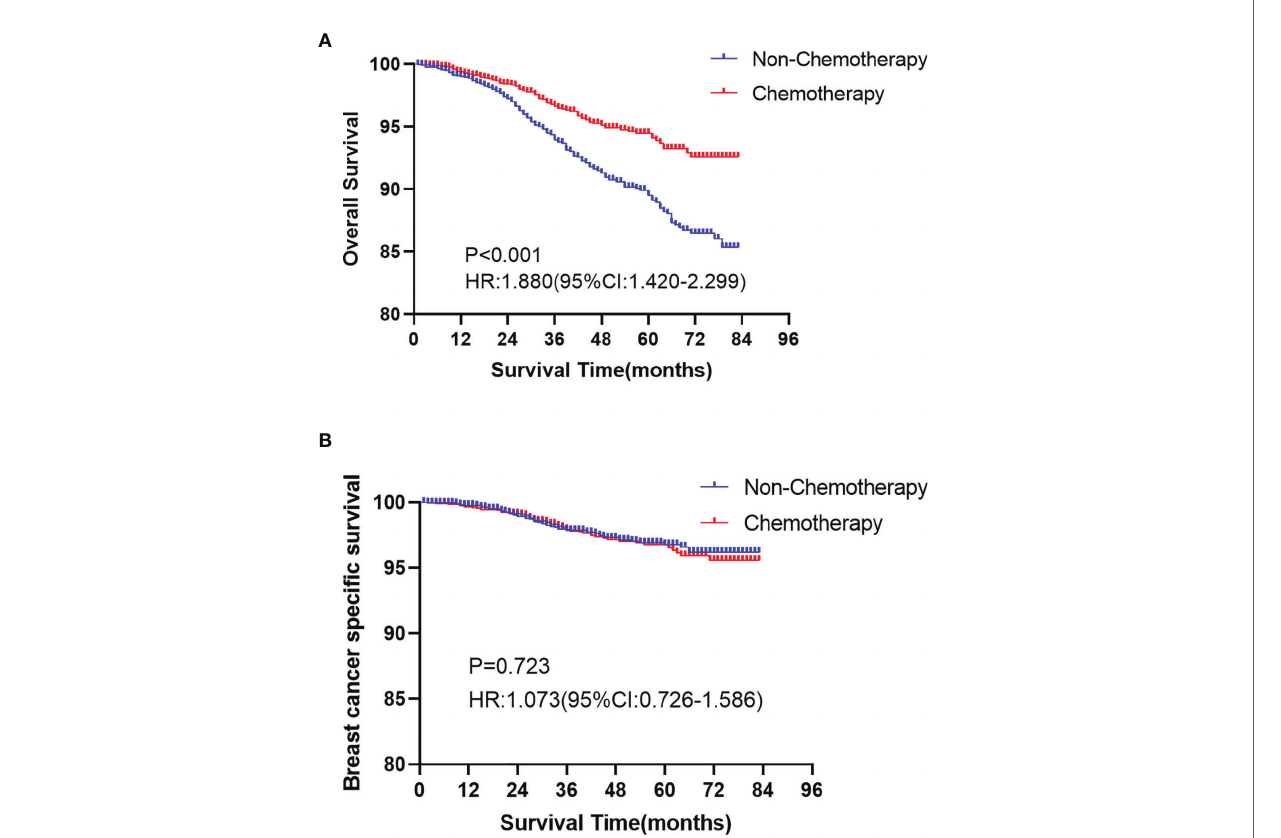
FIGURE 2 | Kaplan-Meier curves analyses of the overall survival (OS, A P < 0.001) and the breast cancer speci fi c survival (BCSS, B P > 0.05) for chemotherapy and non-chemotherapy group in node-negative triple-negative breast cancer with tumor size less than 1